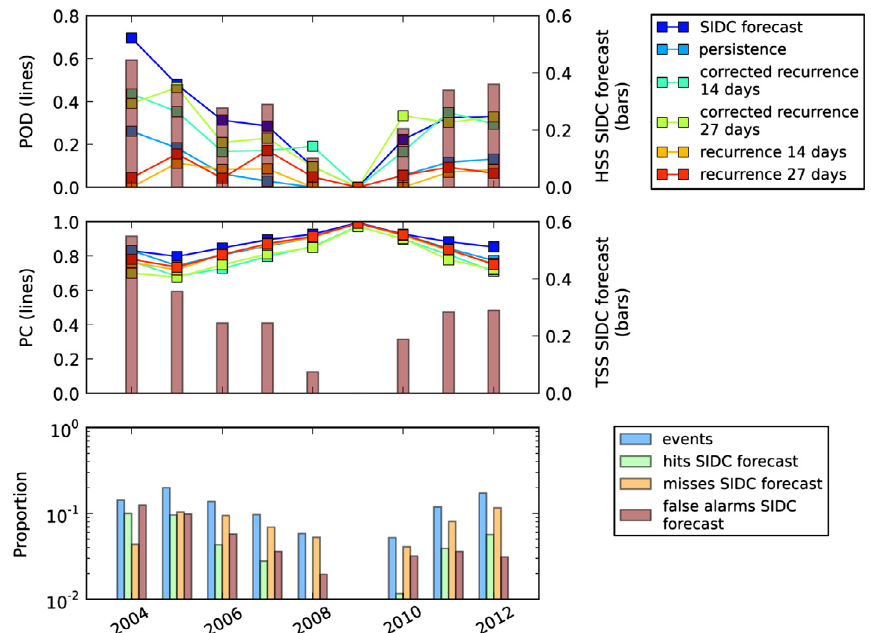
Fig. 8. Evaluation of the SIDC forecast and numerical models to predict a geomagnetic storm with K of at least 5, across the years. Top panel : POD (lines, left vertical axis, Eq. (5)) and HSS (bars, right vertical axis, Eq. (10)). Middle panel : PC (lines, left vertical axis, Eq. (6)) and the TSS (bars, right vertical axis, Eq. (11)). POD and PC are shown for all forecasts, while HSS and TSS only for the SIDC forecast. Bottom panel : the proportion of days with an event, a hit, a miss and a false alarm (on a logarithmic scale). The proportion of hits and the proportion of misses sum up to the proportion of events. Note that some or all verification measures cannot be calculated and are left undefined in case of lack of events or hits (e.g. year 2009). Table 4. Skill scores for the SIDC forecast and numerical models for the forecast of a geomagnetic storm ( K (cid:3) 5). SIDC forecast